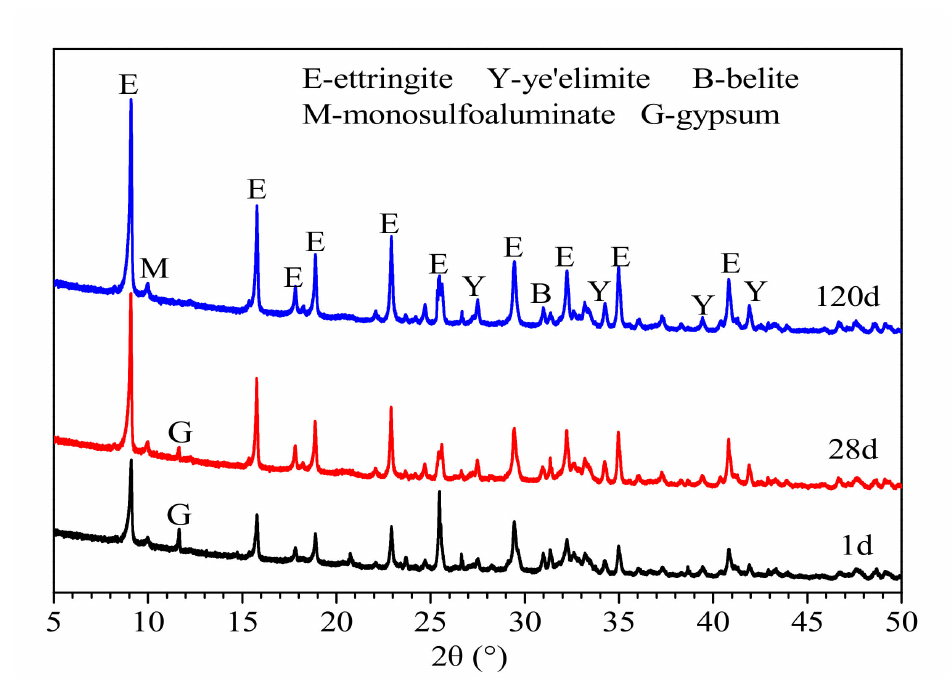
Figure 7. XRD patterns of CSAC-GGBFS mixture blended with 6% FGDG hydrated for different time